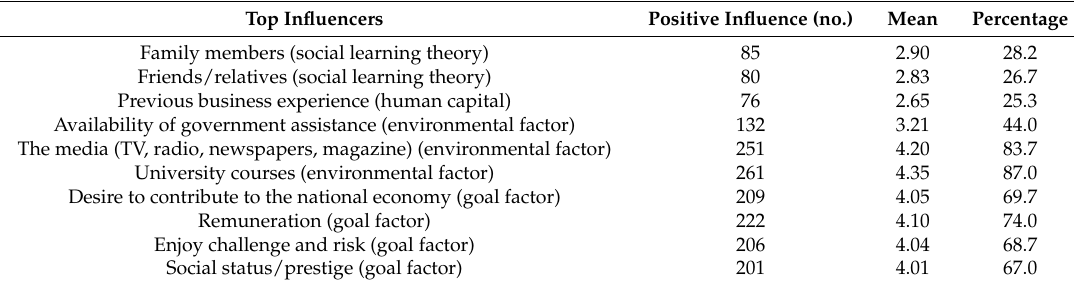
Table 6. Influential motivating factors in starting own